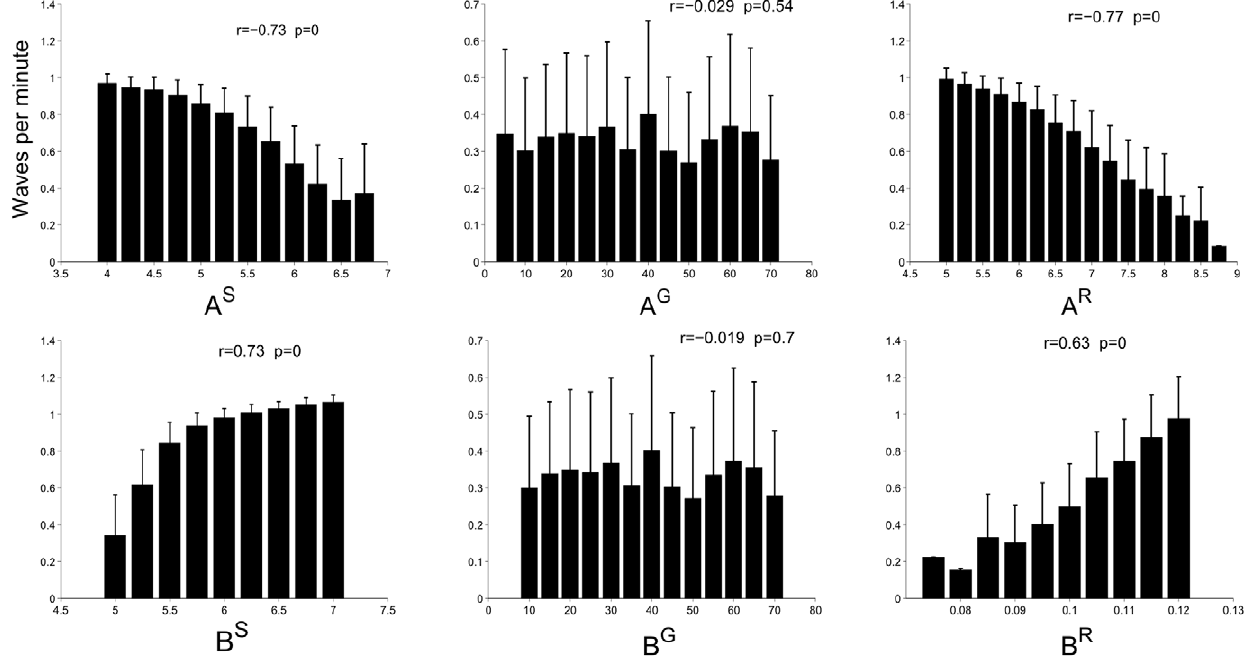
Figure 6. The effect of changing model parameters on waves per minute (WPM). The effects on WPM of varying the following parameters were studied: leak A S and maximum excitability B S in model starburst amacrine cells (SACs)–see (3); similar parameters A G and B G in model retinal ganglion cells (RGCs)– see (10); and other intracellular excitatory B R and inhibitory A R mechanisms in the AHP currents–see (8). Increasing A R or A S decreases WPM, while increasing B R or B S increases WPM. The parameters A G and B G governing the behavior of model RGCs have no significant effect on WPM, indicating that SAC dynamics alter WPM. Means of WPM across multiple simulations are shown, with error bars indicating the standard deviation.